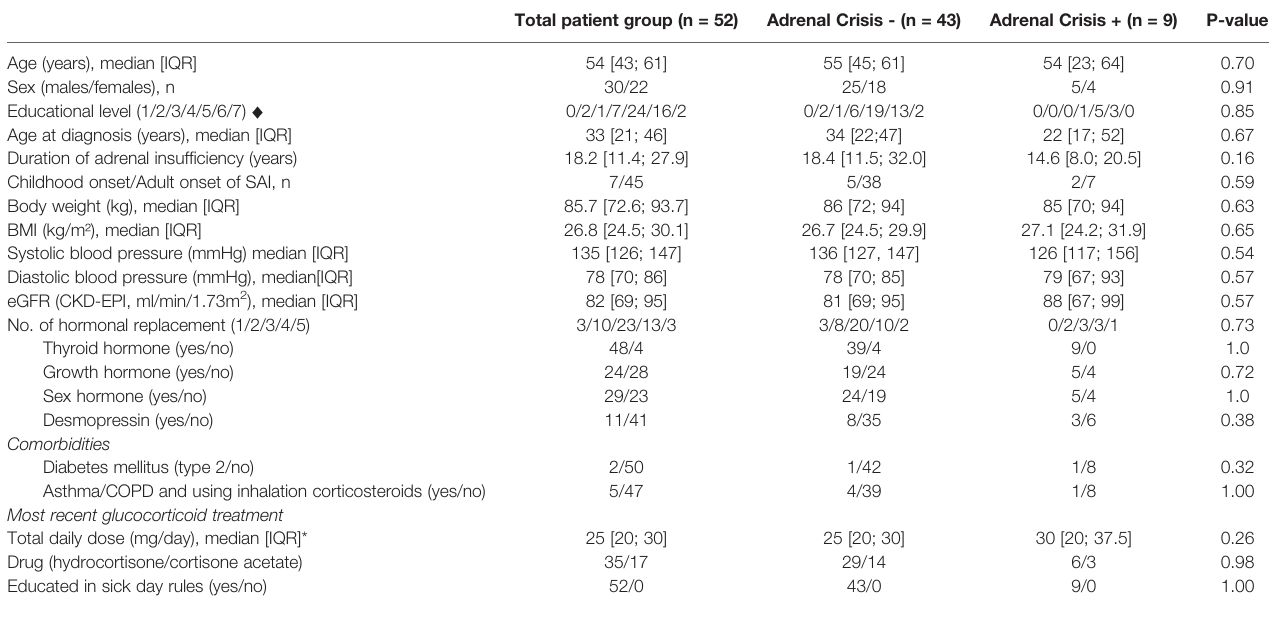
TABLE 1 | Clinical characteristics of patients with secondary adrenal insuf fi ciency with or without a history of an adrenal crisis. Total patient group (n =